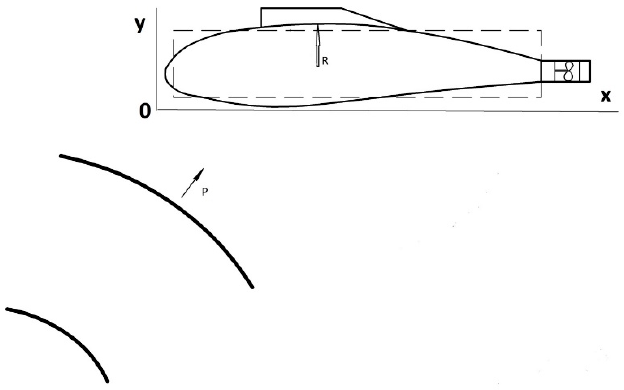
Figure 2. Calculation model of a submersible vehicle affected by a plane wave.